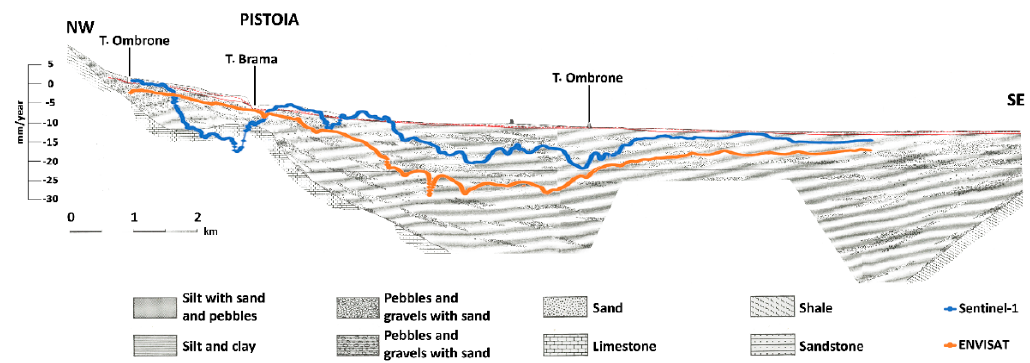
Figure 12. Geological section of Pistoia town (modified from [37]) across to nearly section A-A’ in Figure 10.